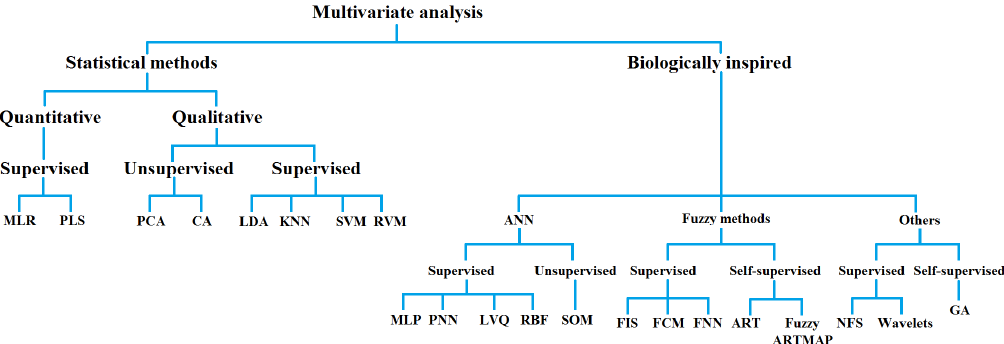
Figure 4. Multivariate data analysis methods organized as statistical or biologically inspired tech- niques.